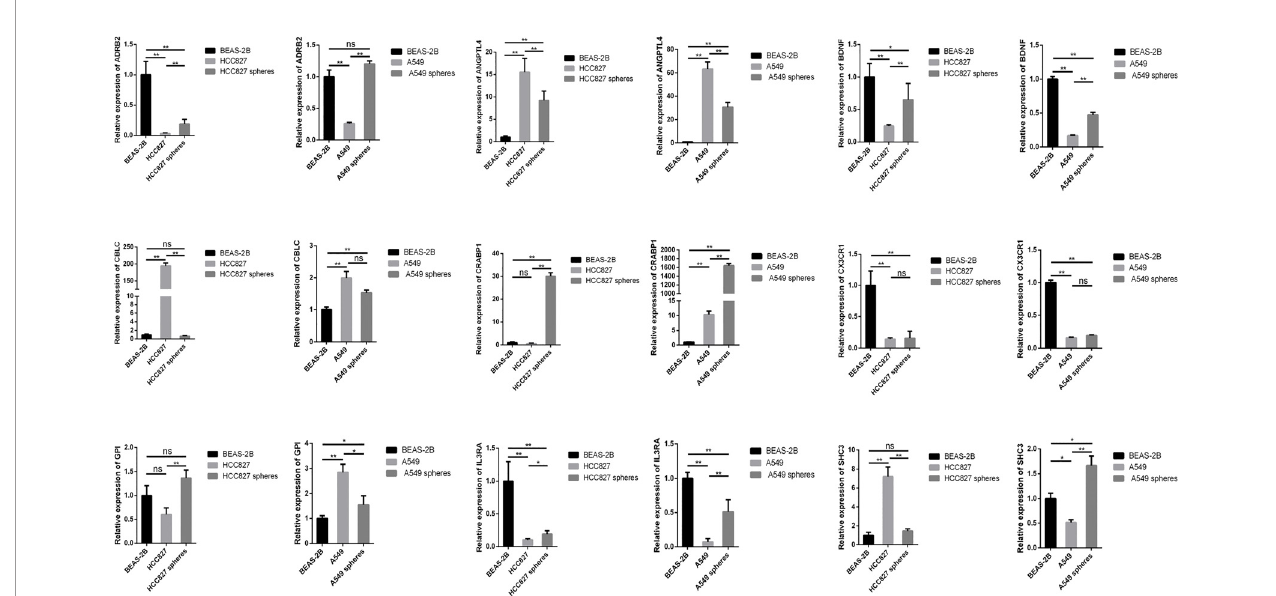
FIGURE 9 | The expression levels of SCIRGs in the model between Beas-2B, HCC827 cell lines, HCC827 cancer stem cell, and results of the RT-PCR to determine gene expression. *p < 0.05, **p < 0.01, ***p < 0.001; ns, no signi fi